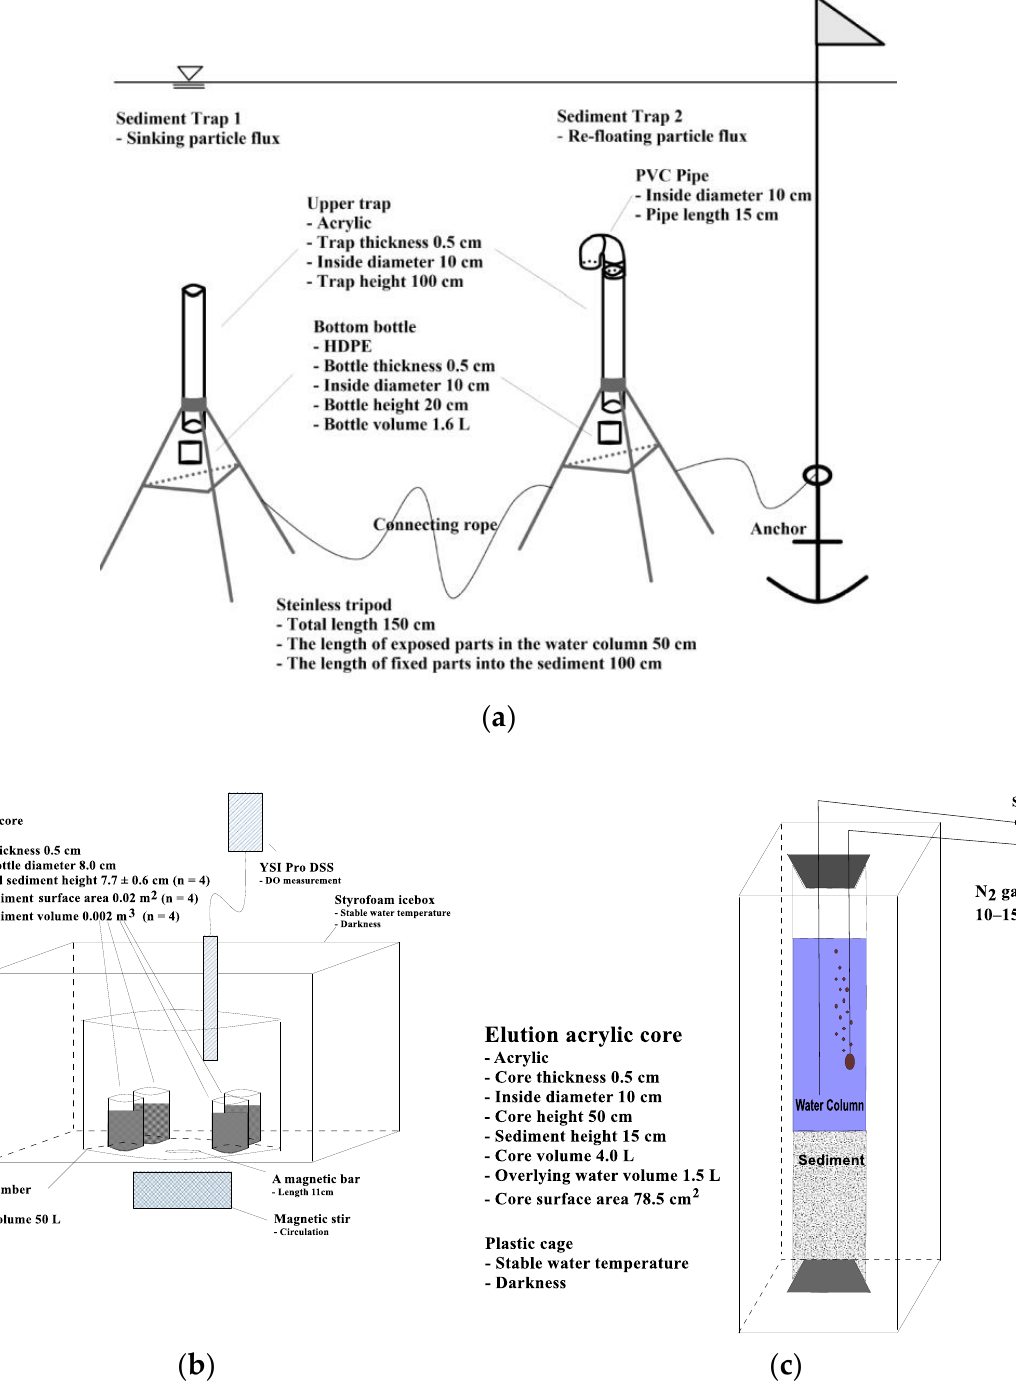
Figure 2. Schemes of the designated instruments to estimate the mass balances: ( a ) sinking/re-floating sediment traps; ( b ) SOD (Sediment Oxygen Demand) chamber; ( c ) ex situ nutrients incubating experiments.